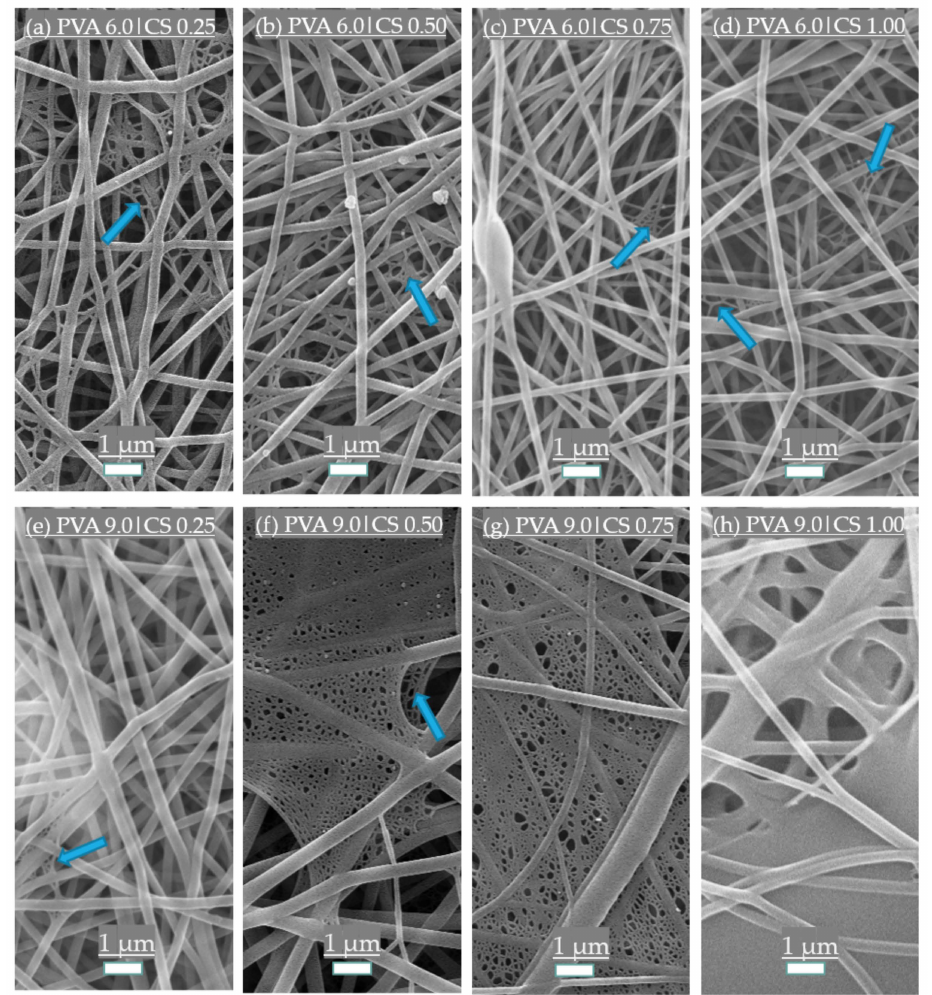
Figure 1. SEM photomicrographs from samples with fixed PVA series at 6.0%: ( a ) CS 0.25; ( b ) CS 0.50; ( c ) CS 0.75; and ( d ) CS 1.00%. A series with 9.0% PVA with ( e ) CS 0.25; ( f ) CS 0.50; ( g ) CS 0.75; and ( h ) CS 1.00% is also presented. Arrows indicate the spider